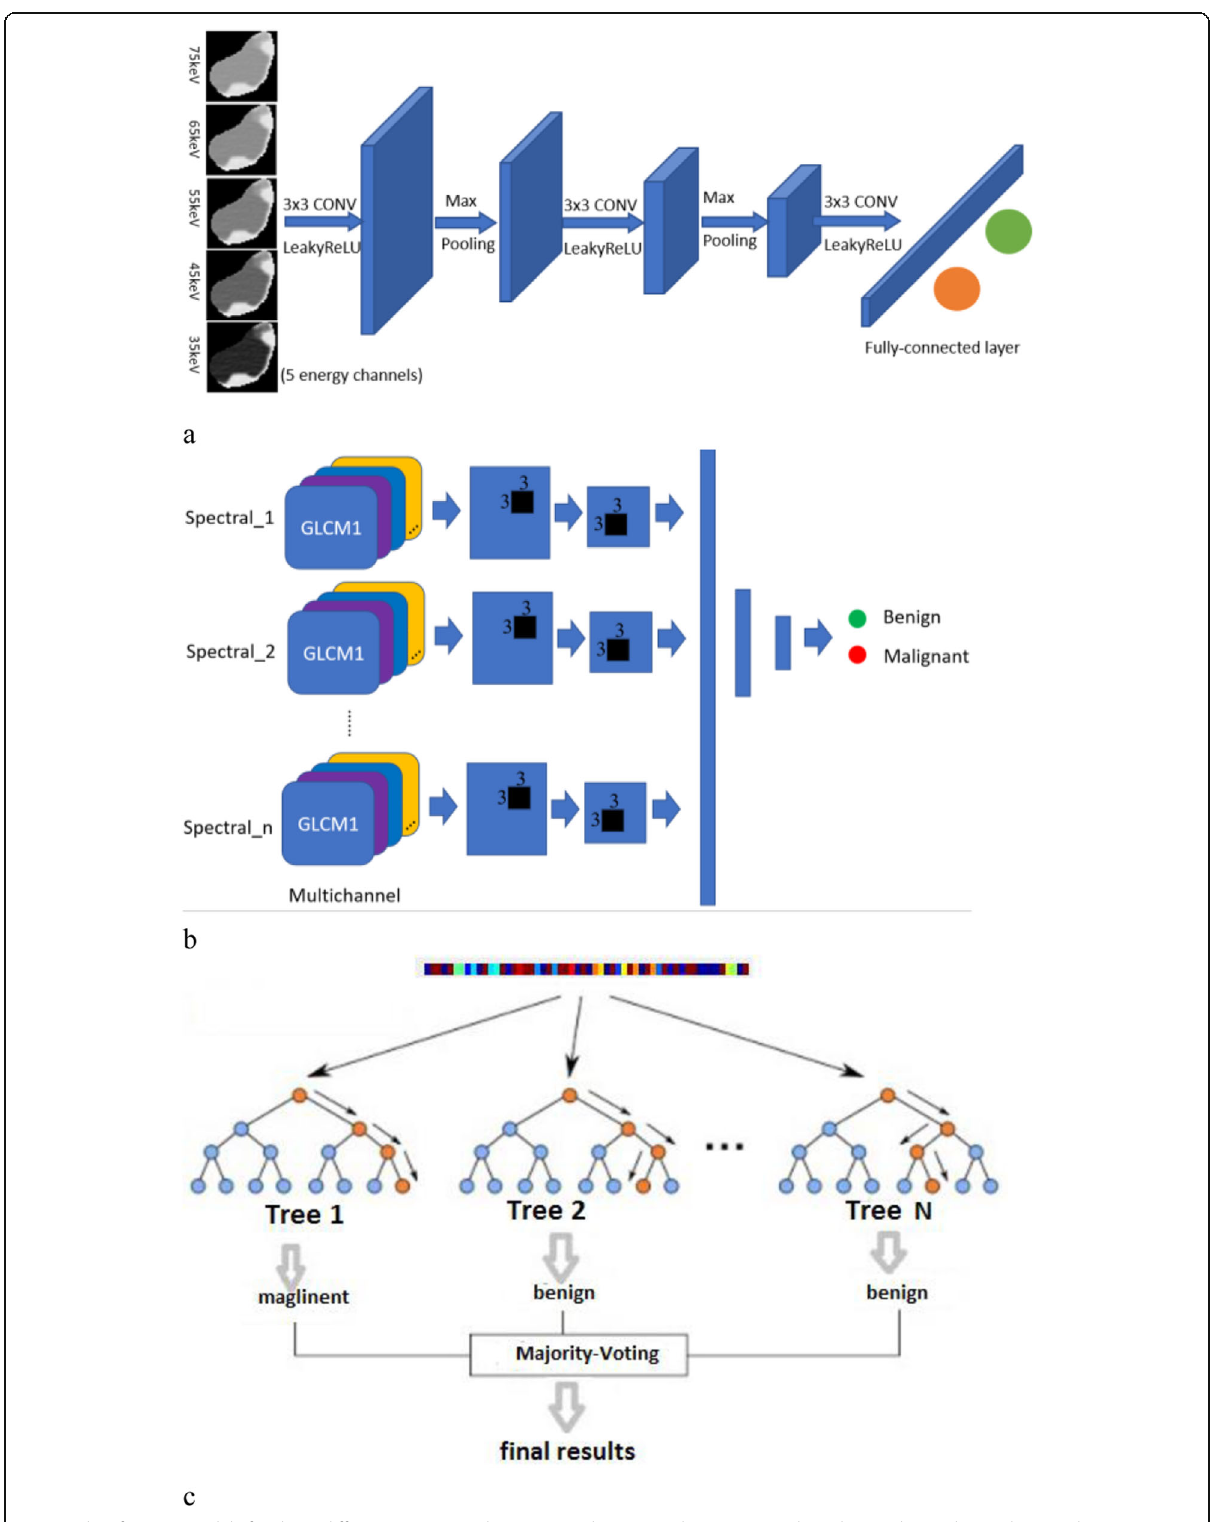
Fig. 5 Classification models for three different inputs: ( a ) the computed tomography raw image-based convolutional neural network (CNN) model, ( b ) the co-occurrence matrice based CNN model and ( c ) the Haralick feature based random forest